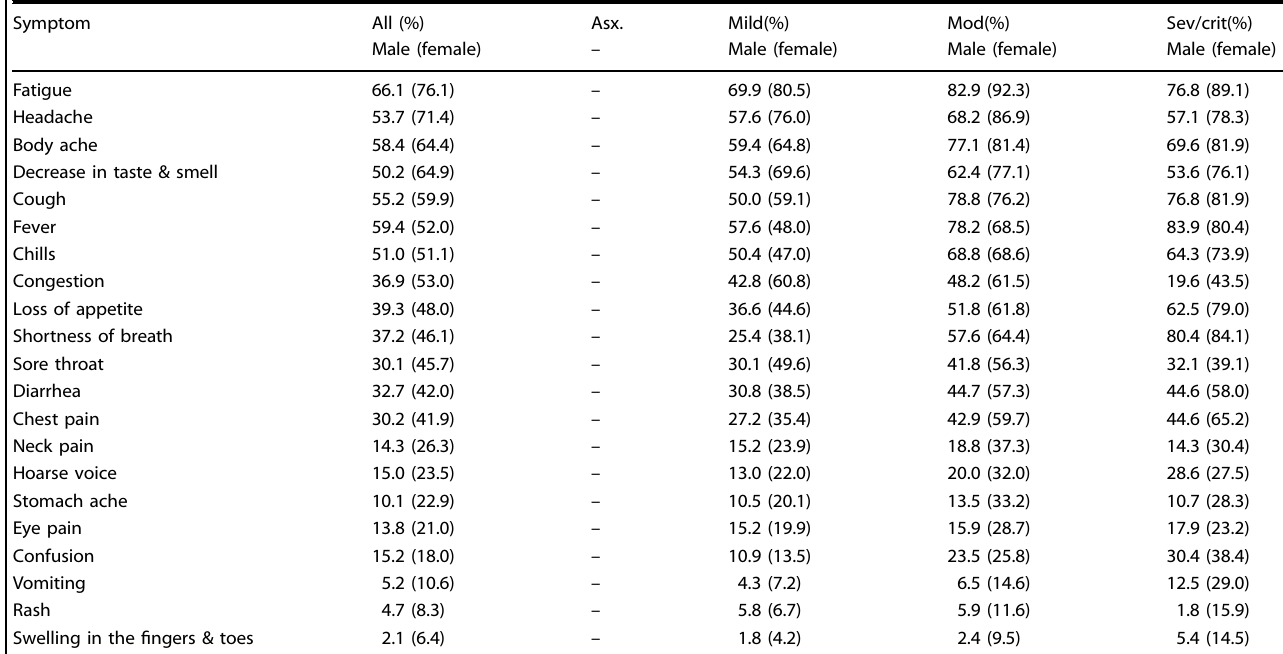
Table 4. Prevalence of